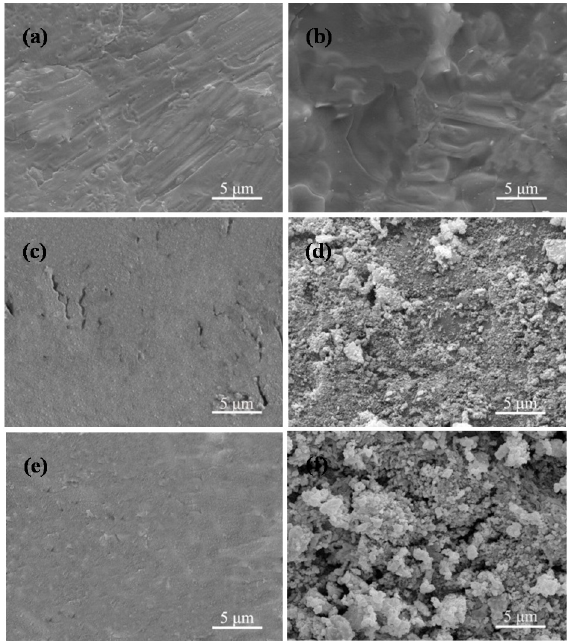
Figure 8. The morphological features of CaSO 4 , CaSO 4 /5 wt % 45S5 bioglass scaffolds after soaking in SBF for ( a , b ) zero day; ( c , d ) one day and ( e , f ) four days.